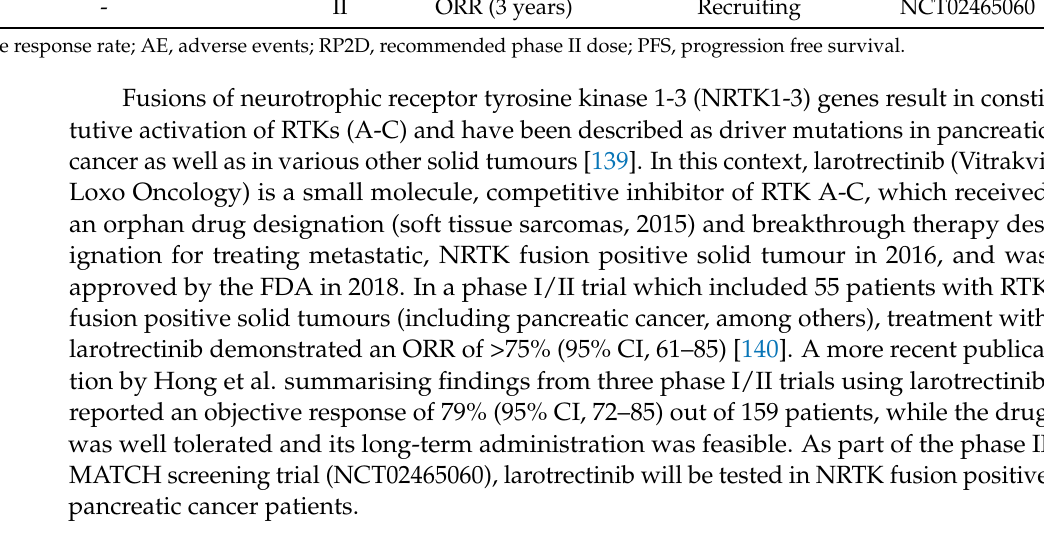
Table 8. Current phase II clinical trials using PI3K/AKT7mTOR inhibitors for the treatment of pancreatic cancer. Drug Combination Phase Primary Outcome Status ID Seribantumab - II ORR (12 months) Recruiting NCT04383210 ABTL0812 Gemcitabine plus